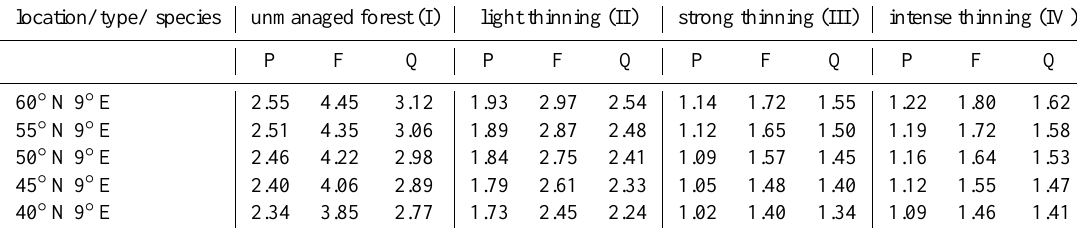
Table 1. Mean effective LAI over one rotation for the different thinning strategies, tree species and locations. P: Pinus sylvestris L.; F: Fagus sylvatica L.; and Q: Quercus robur L. or Q. petraea Liebl.(I) unmanaged forest: the forest stand is an even-aged forest and no management measures are applied. (II) light thinning: the forest stand is thinned from below according to yield tables. The trees with the smallest diameters are removed until the required density from the yield table is reached. This is repeated every 5years. (III) strong thinning: this measure is similar to (II) but only half the density of the yield tables is applied, i.e. more trees are removed than in the simulations (II). (IV) intense thinning: this measure is similar to (III) but the thinning occurs only every 10years, to the same density as (III) for the same age.